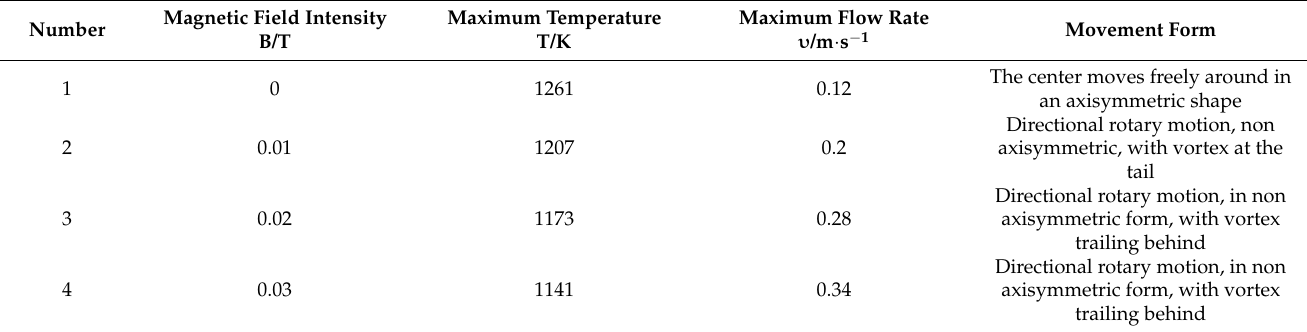
Table 2. Morphological data of molten pool under different magnetic field strength.